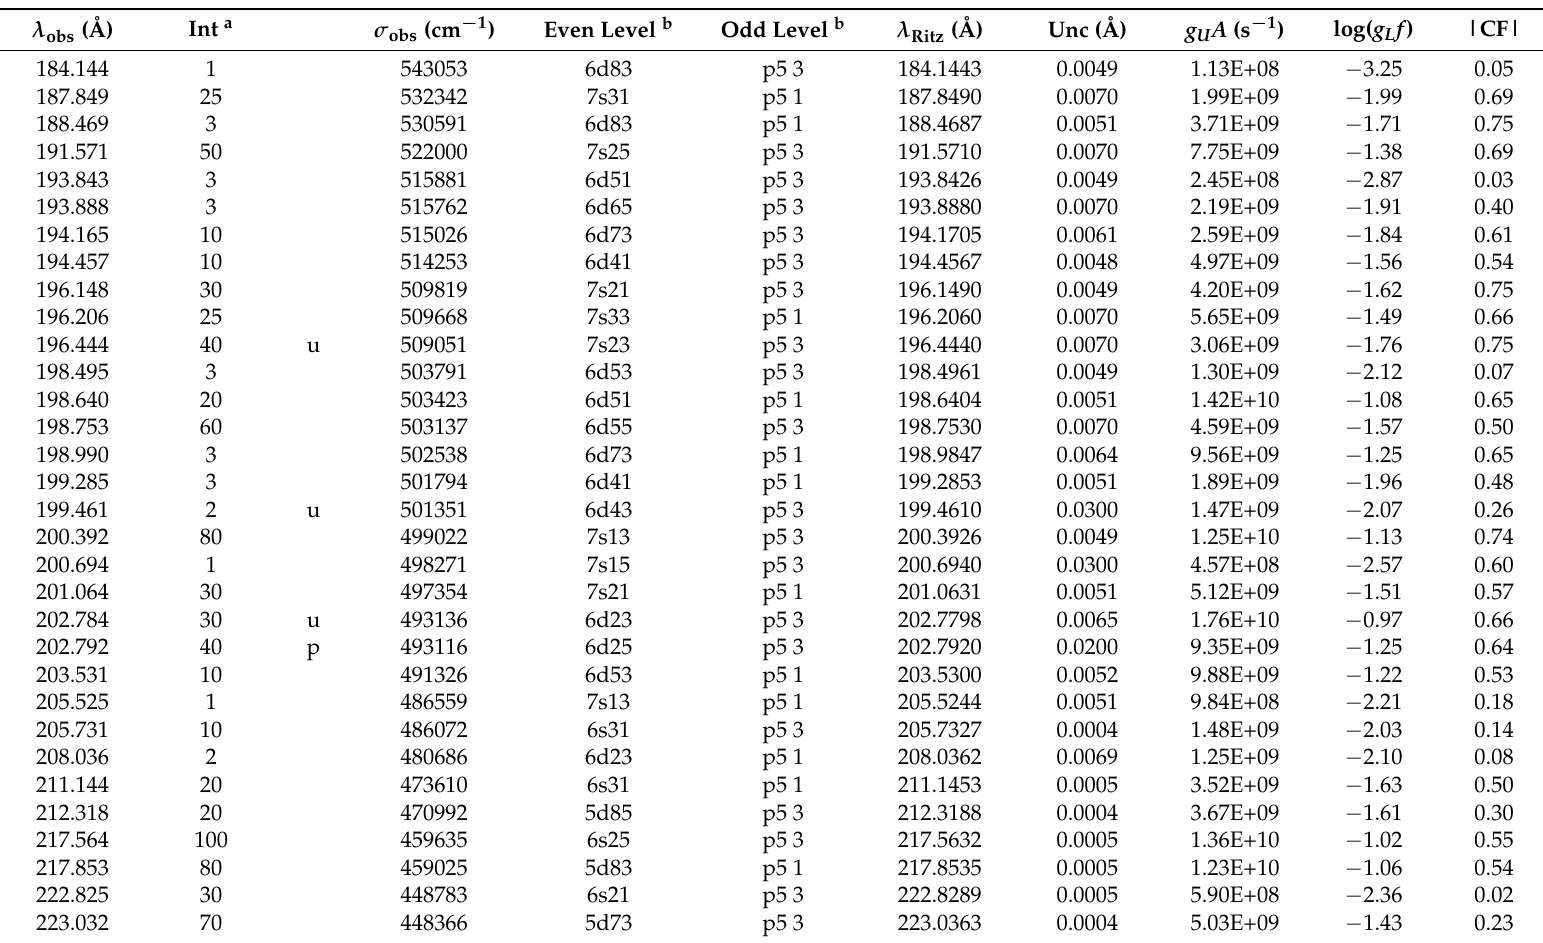
Table 1. Observed spectral lines of Y V. Wavelengths and wave numbers are in vacuum. Wavelength values in parentheses are Ritz values. General uncertainty of the observed wavelengths is ± 0.007 Å. Uncertainties for less certain wavelengths are given in Section 2 of the text. |CF| is the cancellation factor (see text). Unc (Å) is the uncertainty of the Ritz